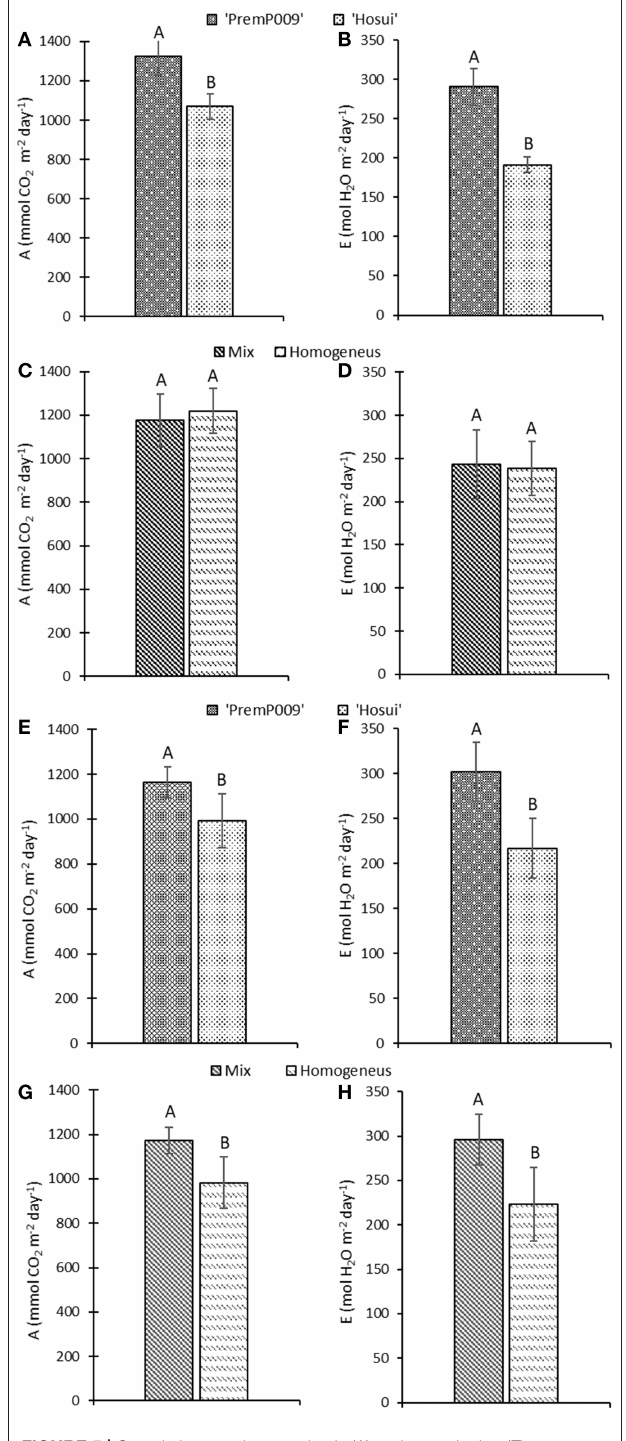
FIGURE 5 | Cumulative net photosynthesis (A) and transpiration (E) ( ± Standard Error, SE) over the time of daily measurements on January 15th (A–D) and February 19th (E–H) . Measurements consider leaf genotype (‘PremP009’ and ‘Hosui’) and plant type (Homogeneous or Mixed). Each bar represents the cumulative mean ± SE of four replicates. Letters on the histograms indicate the mean separation. P <